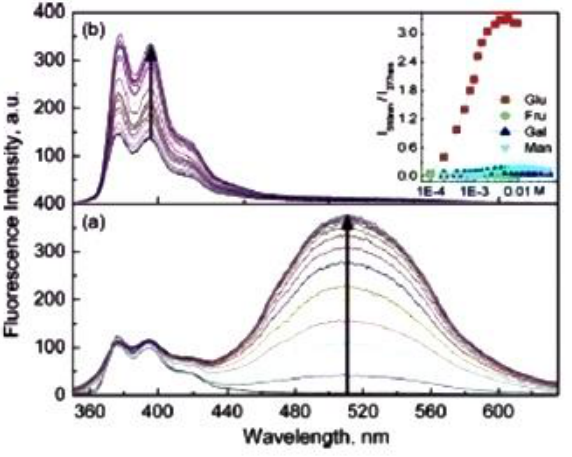
Figure 9. Fluorescence spectra recorded in a carbonate buffer (pH = 10) containing 2% methanol. ( a ) Glucose and ( b ) fructose, both in a concentration range from 0–10 mM. Insert I (a) shows the ratio between the excimer and monomer as a function of concentration and carbohydrate (Reprinted with permission from [68]. Copyright 2013 American Chemical